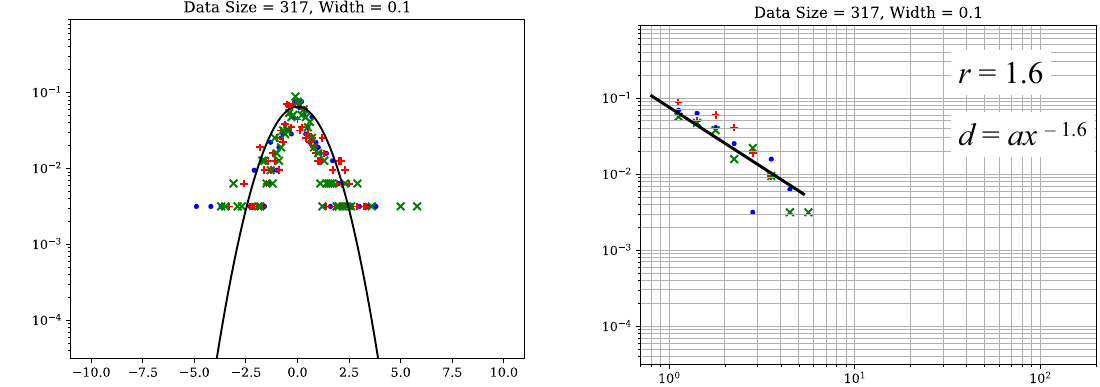
Fig. 6 PDF of real-observed past time series. a Left: linear-log plot. b Right: log–log